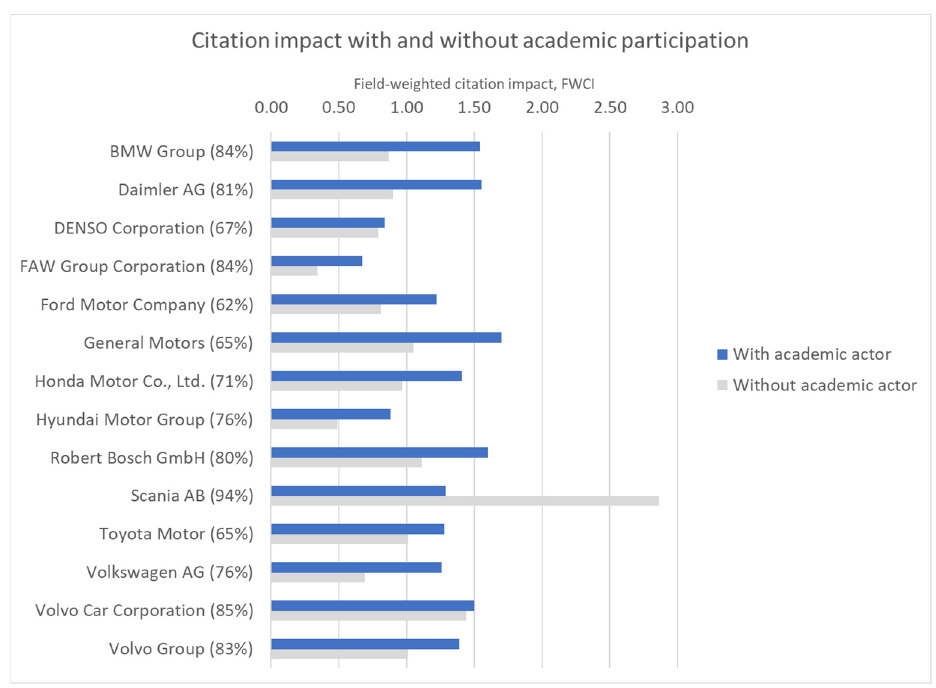
Figure 7. Automaker publications with and without academic actors in 2017–2021.